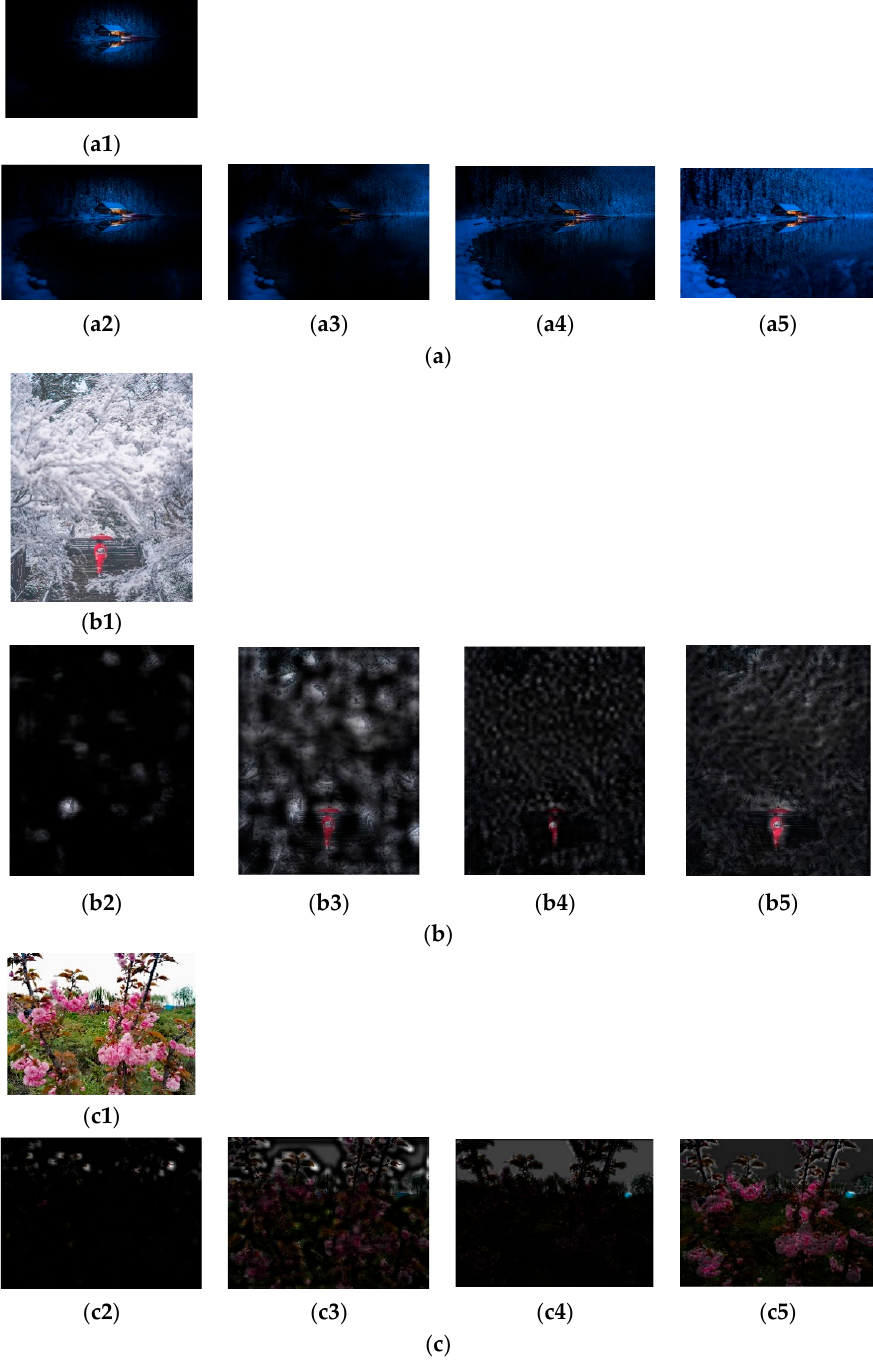
Figure 8. Several examples of the images’ FFPs and AIRs. ( a ) ( a1 ) Original image. ( a2 ) FFP by Ares. ( a3 ) AIR by Ares. ( a4 ) FFP by B4. ( a5 ) AIR by B4. ( b ) ( b1 ) Original image. ( b2 ) FFP by Ares. ( b3 ) AIR by Ares. ( b4 ) FFP by B4. ( b5 ) AIR by B4. ( c ) ( c1 ) Original image. ( c2 ) FFP by Ares. ( c3 ) AIR by Ares. ( c4 ) FFP by B4. ( c5 ) AIR by B4.